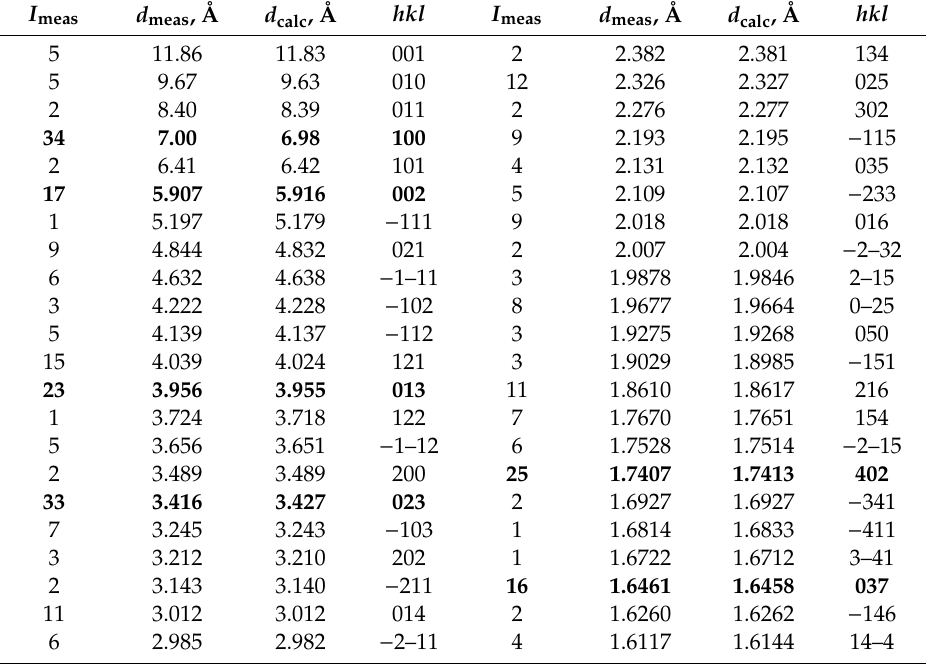
Table 3. X-ray powder-diffraction data for chirvinskyite.